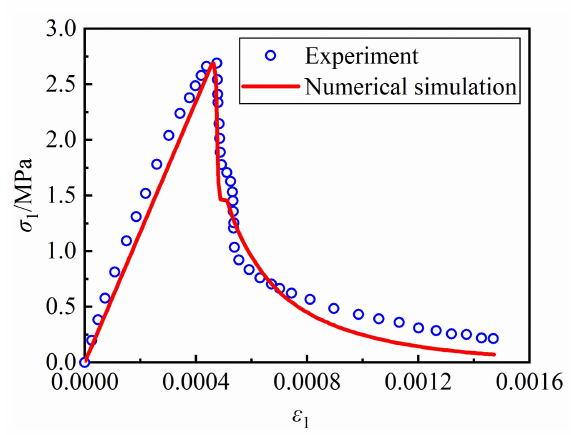
Figure 19. Uniaxial tensile stress-strain relationship of Brisbane tuff.